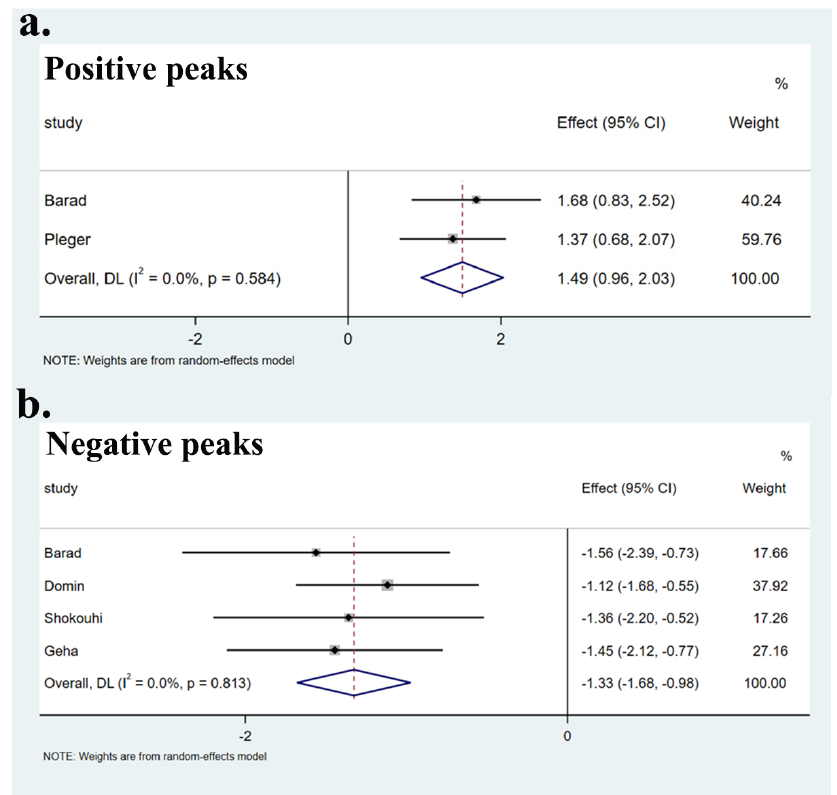
Figure 3. Forest plots of heterogeneity of main results. Heterogeneity assessment of the main results showed no heterogeneity in both positive peaks ( a ) and negative peaks ( b ) ( p > 0.05).